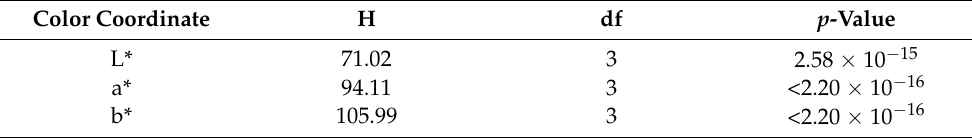
Table 4. Kruskal–Wallis test results.